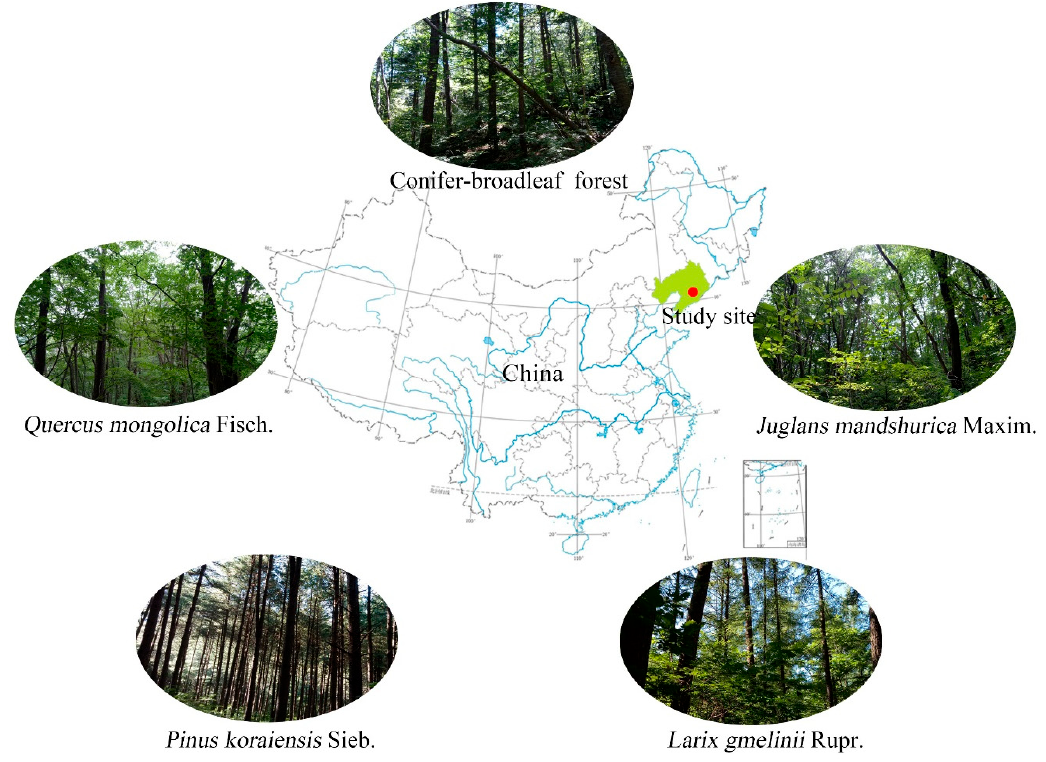
Figure 1. Map showing sampling location of the study.